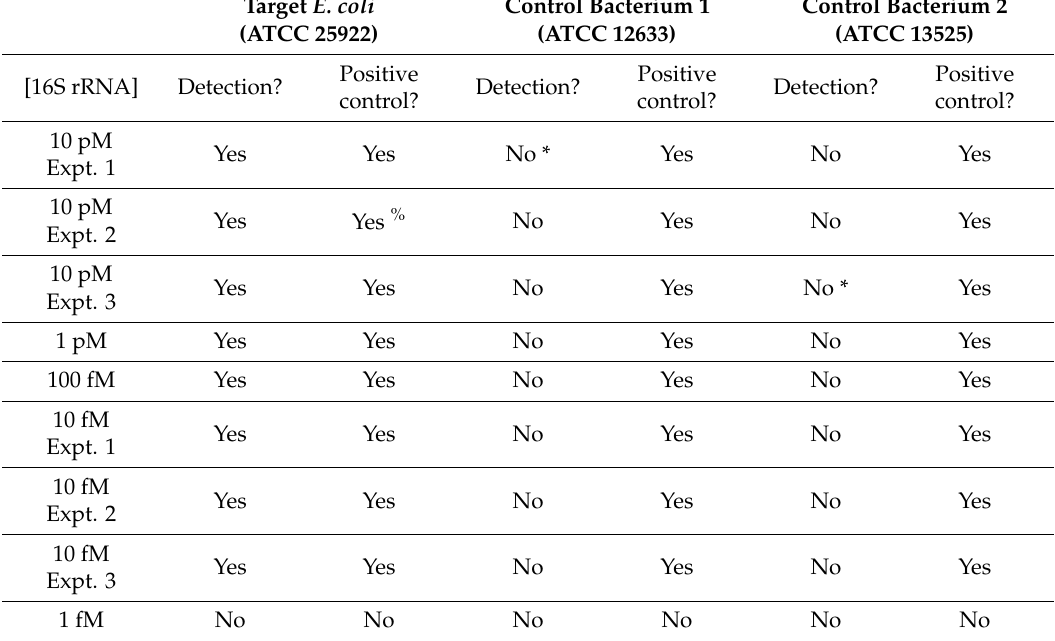
Table 1. Summary of experiment (Expt.) results for target and control samples based on their 16S rRNA concentration. A positive result was defined as a blockade that persisted for >60 s and that was reversible by reversing the field polarity. A negative result was defined as the observation of either no block or a transient block (<60